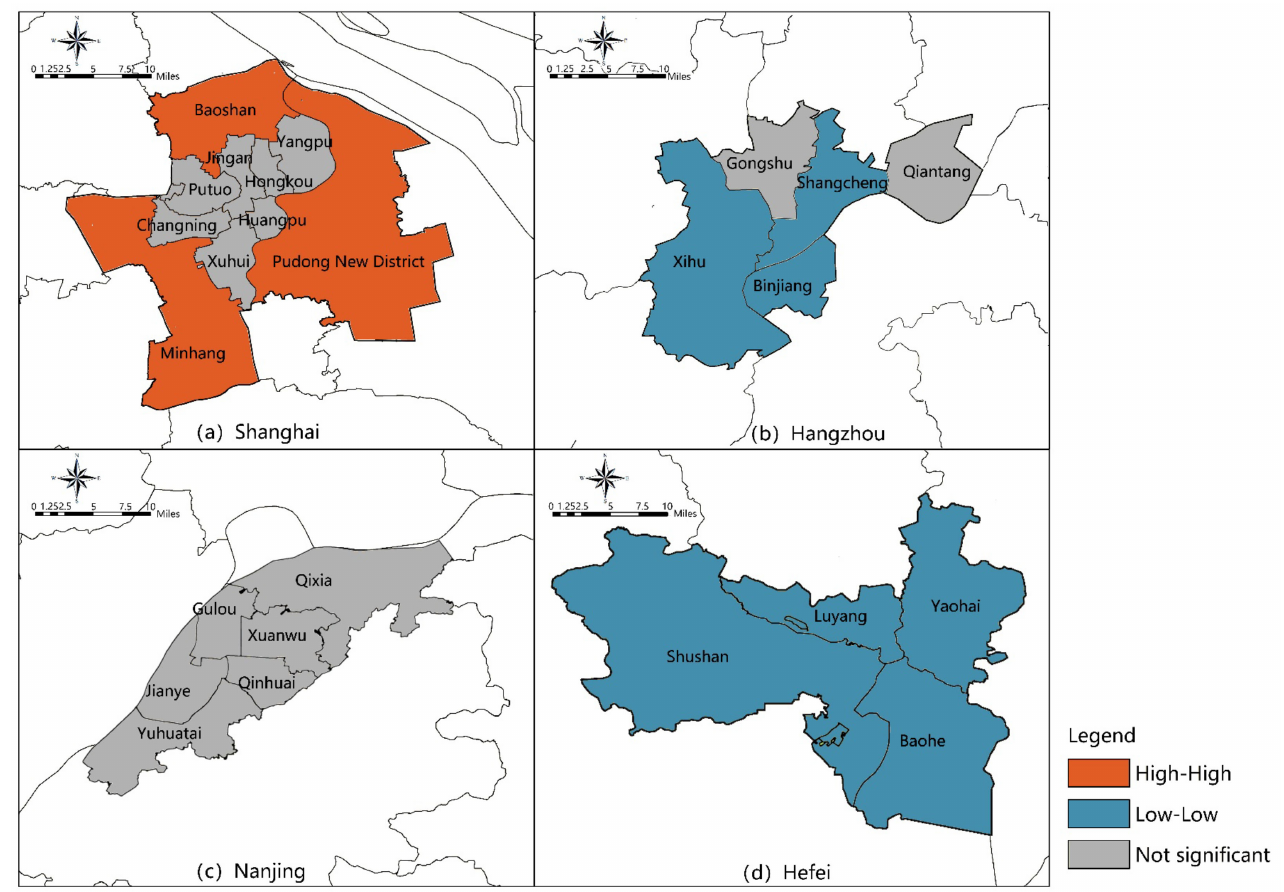
Figure 7. The LISA map of the CDI of the administrative districts in the main urban areas of the four central cities in the